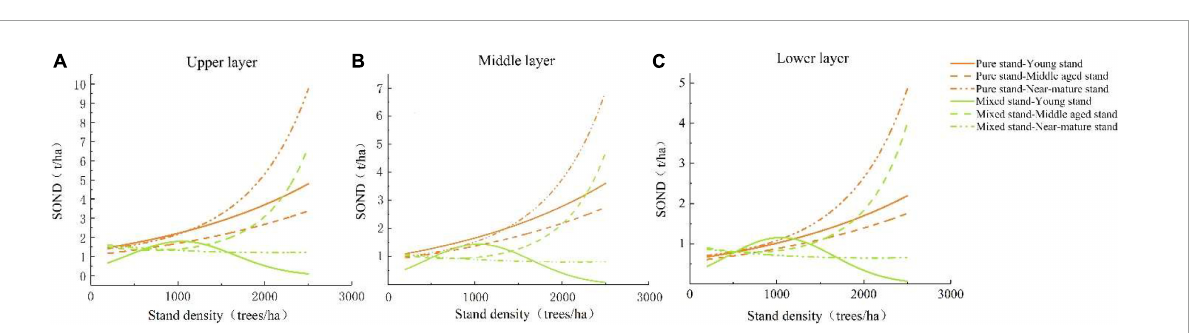
FIGURE5 Storage (SOND) with different stand densities and different age groups at different depths in pure and mixed P. massoniana stands. (A) SOND in the upper soil layer with different stand densities and different age groups in mixed and pure P. massoniana stands; (B) SOND in the middle soil layer with different stand densities and different age groups in mixed and pure P. massoniana stands; (C) SOND in the lower soil layer with different stand densities and different age groups in mixed and pure P. massoniana